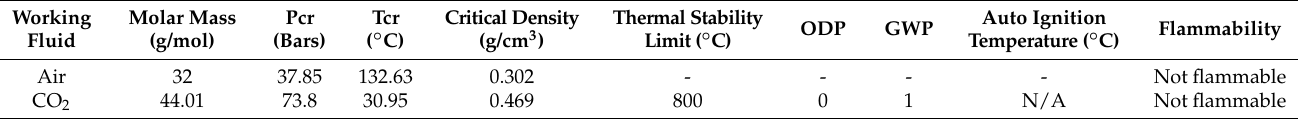
Table 1. Important thermophysical and environmental properties of working fluids.